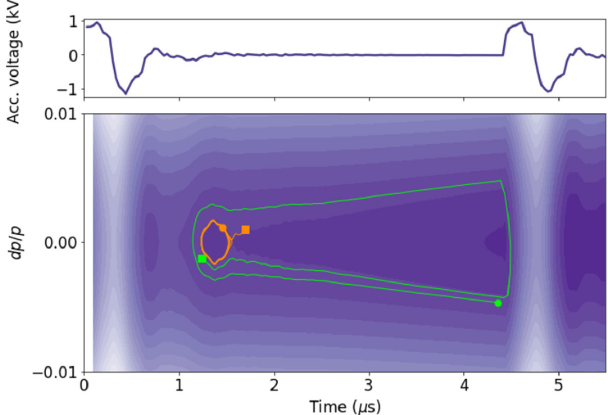
FIG. 6. Poincar´e plot of the two particle trajectories inside a fixed bucket over 350 turns. The orange and green particles move to the inner and outer equipotential lines, respectively.